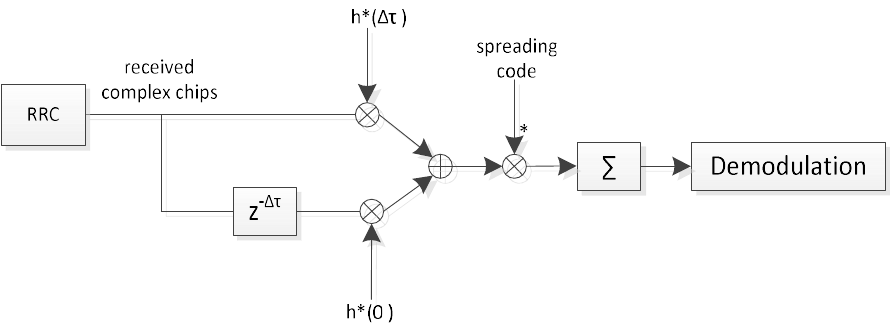
Figure 5. Rake receiver with two rake fingers for channel equalization.